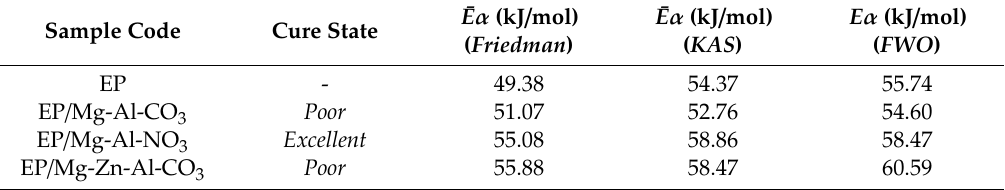
Table 3. The kinetic parameters obtained for the studied systems.